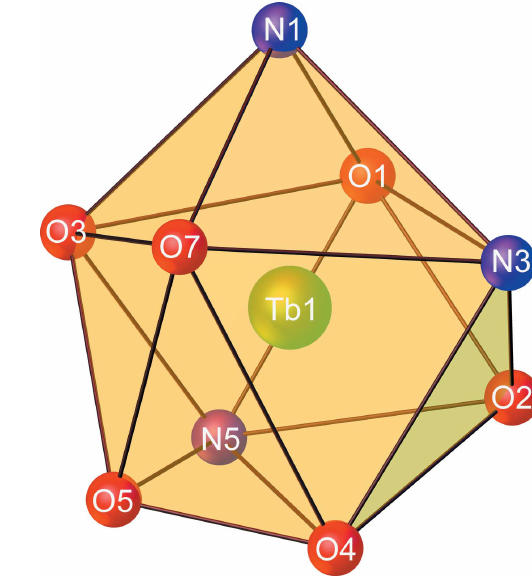
Figure 2 View of the distorted tricapped trigonal–prismatic coordination geometry of the central Tb 3+ atom in 1 .